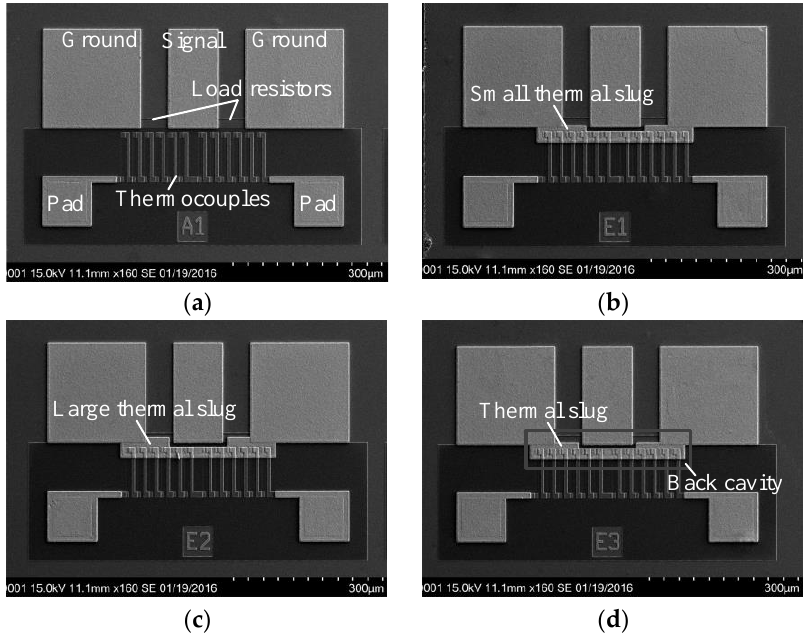
Figure 1. SEM views of four n + GaAs/AuGeNi-Au thermocouple-type RF MEMS power sensors based on GaAs MMIC process. ( a ) Sensor A1 with a basic structure. ( b ) Sensor E1 with a small thermal slug. ( c ) Sensor E2 with a large thermal slug. ( d ) Sensor E3 with a thermal slug and a back cavity (dual thermal flow paths).